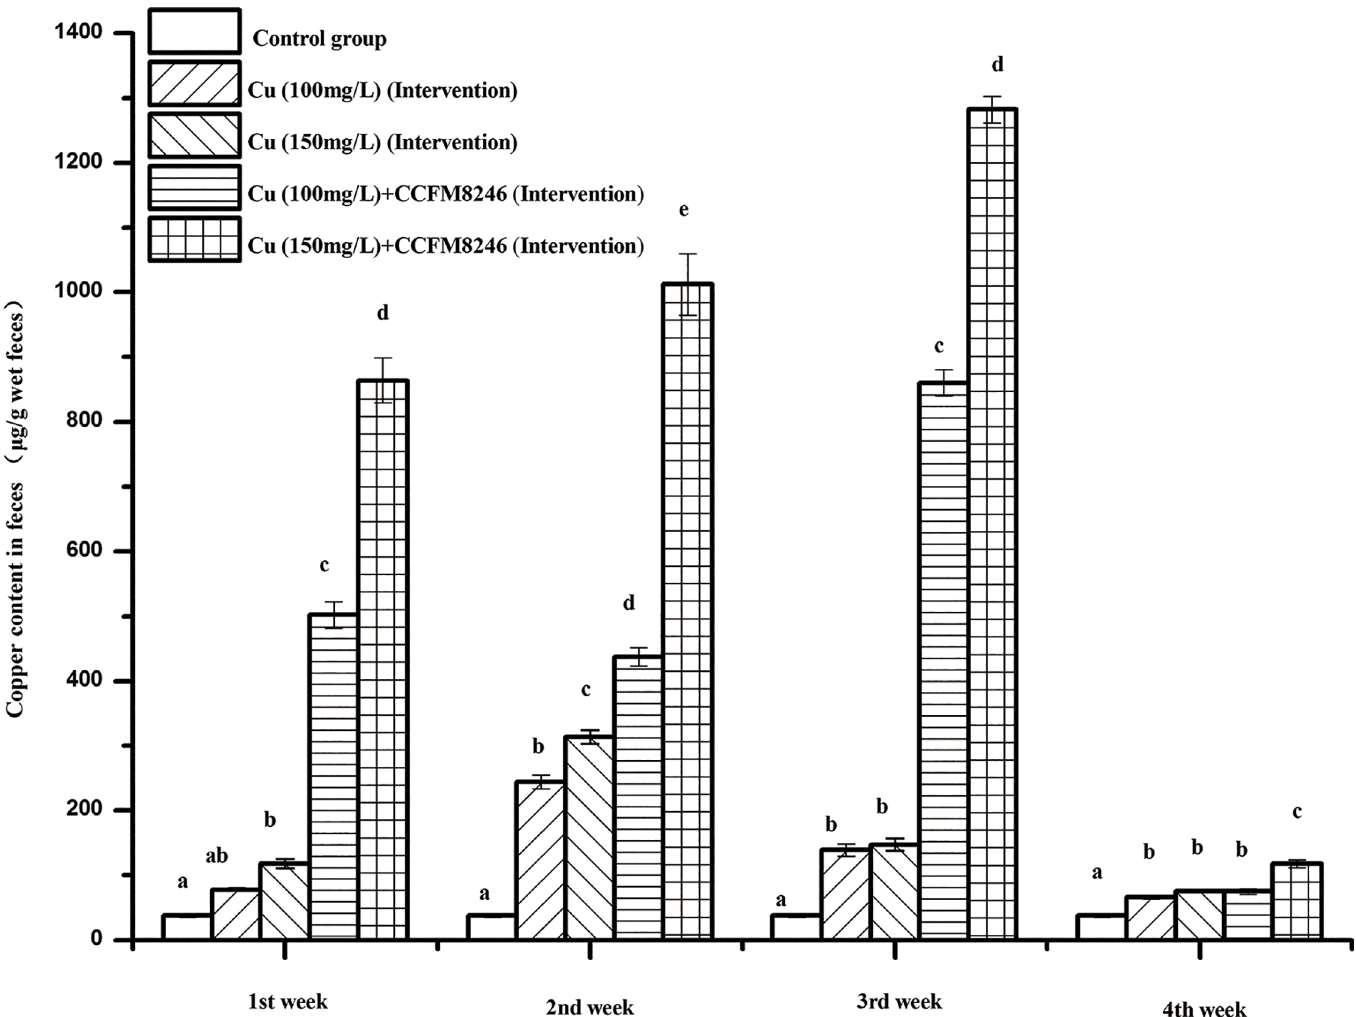
Fig 5. Copper content in wet feces of mice in intervention groups. Values are mean ± SEM with 10 mice in each group. The letters a, b, c, d and e mean that in each period, groups with different letters differ significantly ( p <